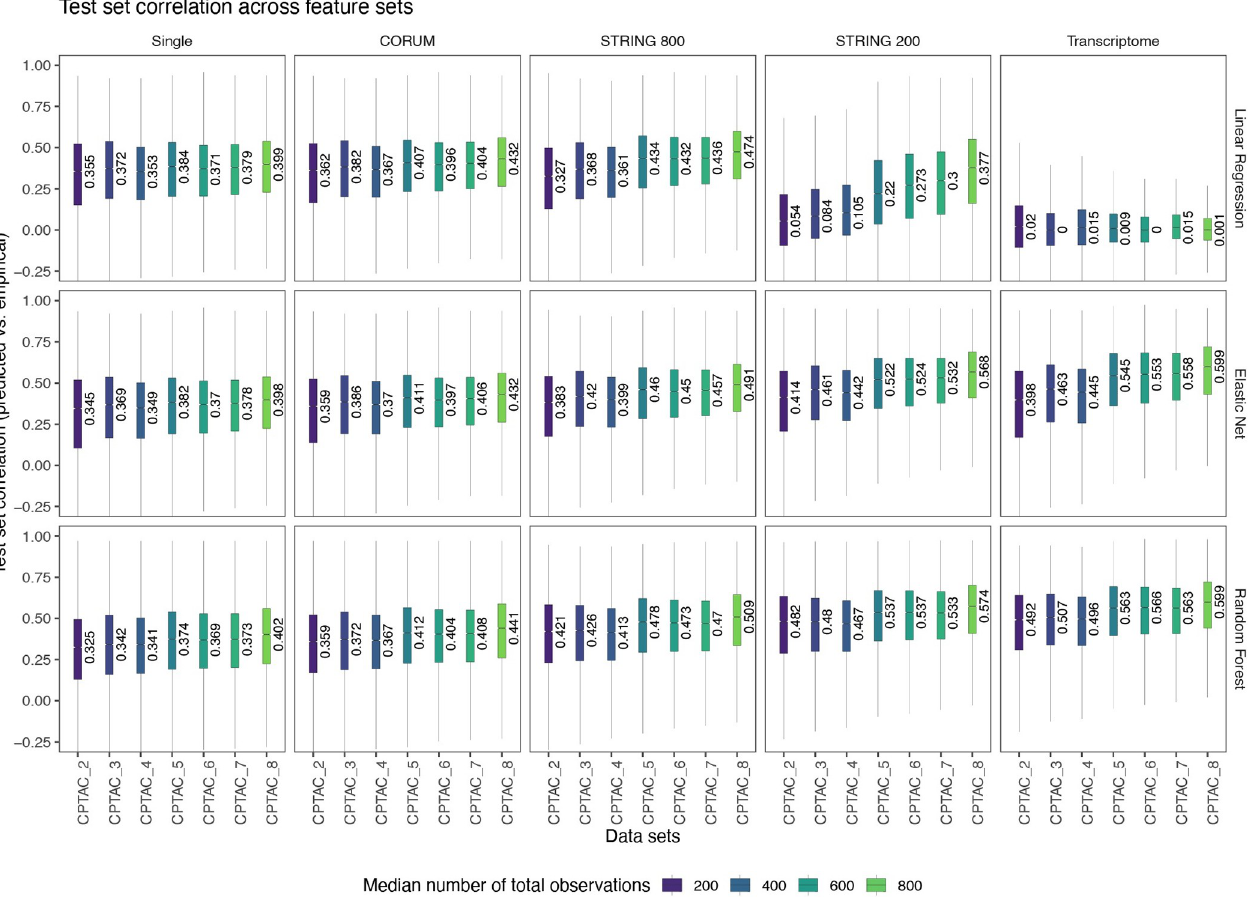
Fig 1. Genewise dispersion of protein predictability from transcriptome data. Box plots of test set correlation coefficients between the transcript-predicted and actual protein level for each protein are shown across five feature sets (column: single/self transcript, CORUM interactors, STRING 800 high-confidence associated proteins; STRING 200 low-confidence associated proteins, and all transcripts) and three algorithms (multiple linear regression, elastic net, and random forest). In each plot, the x axis denotes the number of additive CPTAC data sets used to train the models as described in Methods; box: interquartile range; whiskers: +/– 1.5 IQR; notch: